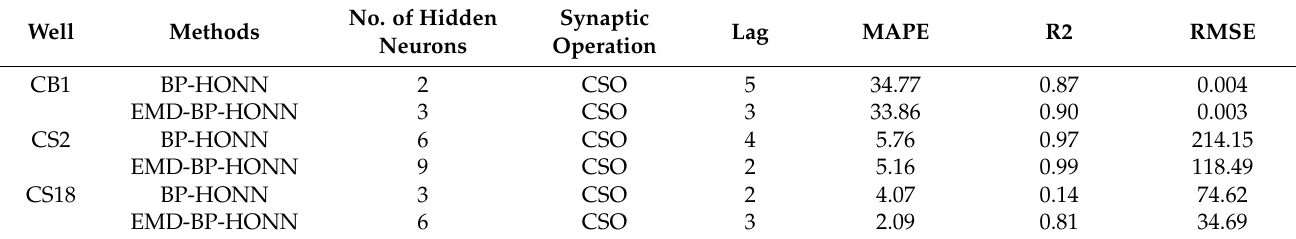
Figure 8. Prediction result of EMD-BP-HONN for CS18. Table 3. Best result of HONN-based methods on several wells.